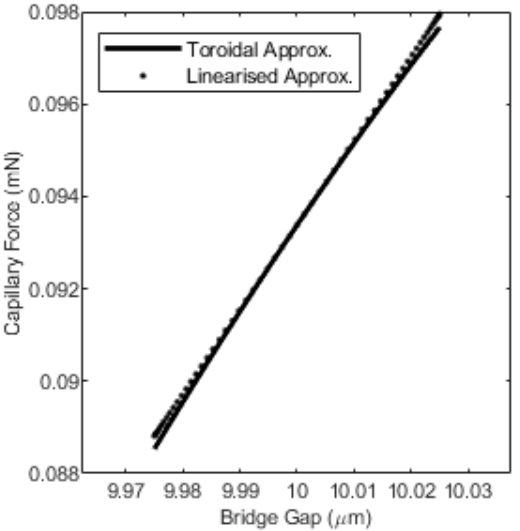
Figure 13. Linearised capillary force. Note that, as an example, the amplitude has been here reduced to 25 nm and, as a result, the contact radius is not able to slip, hence the capillary force is essentially linear.